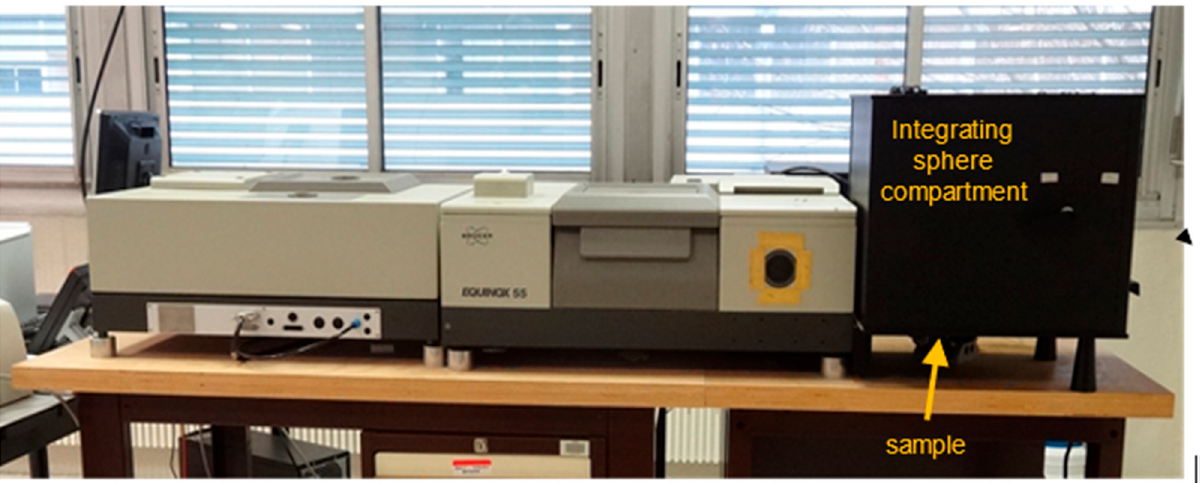
Figure A9. Bruker Equinox 55 with its integrating sphere in ONERA. The sample is on the lifting platform below the sphere.